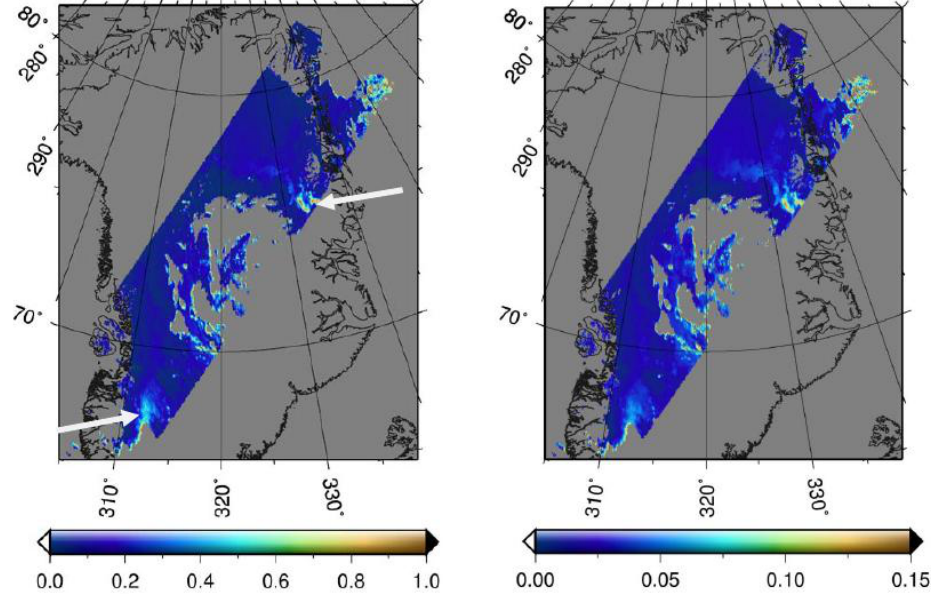
Fig. 15. The map of retrieved AOT over Greenland on 5 July 2008, 14h 46min 02s, orbit number 33187 (left panel). Arrows indicate increased AOT near Kangerlussuaq (left bottom corner), where a dust event has been observed on 4 July 2008 (see Fig. 13), and on the NE-Greenland (right upper corner), where the same mechanism of dust mobilization is expected. The 3.7µm reflectance map of the same scene (right panel) shows the same pattern as the AOT.